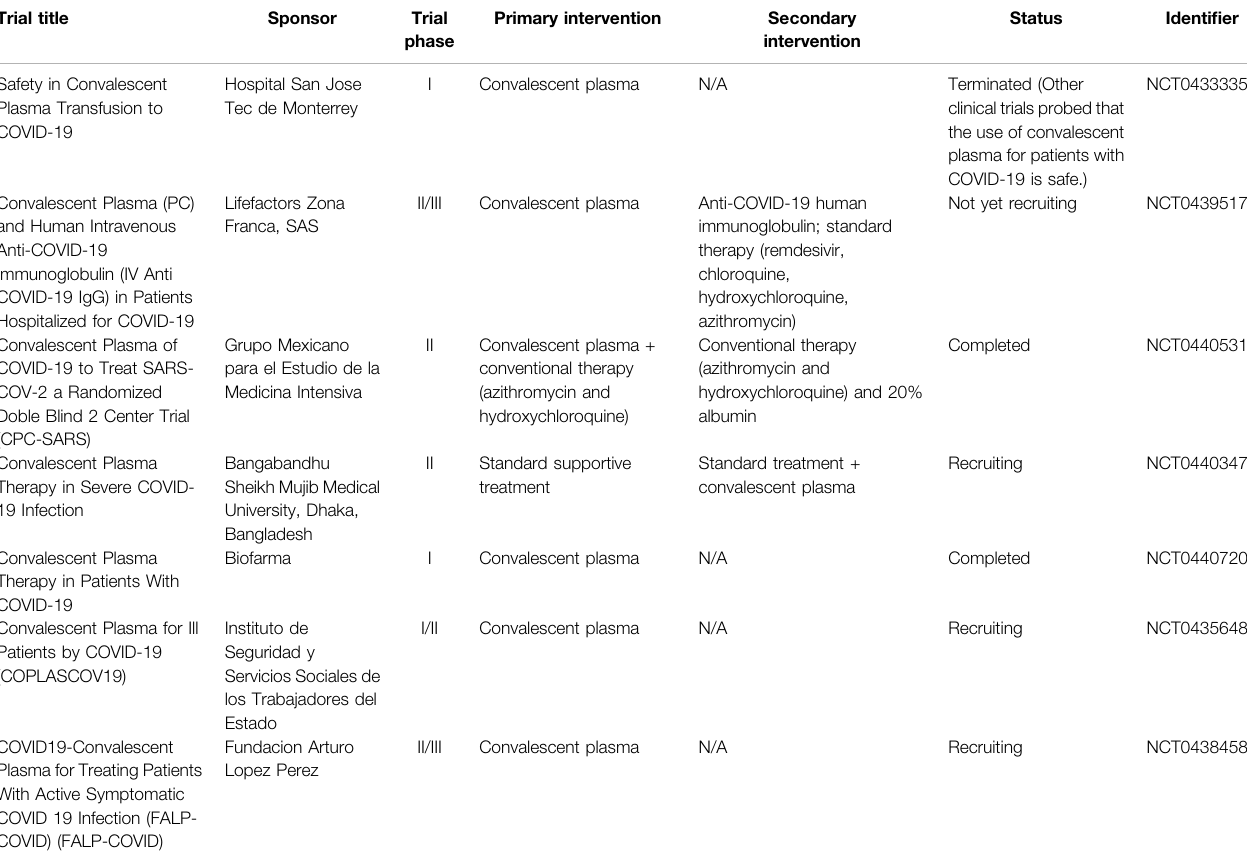
TABLE 9 | Summary of clinical trials of convalescence plasma on COVID-19